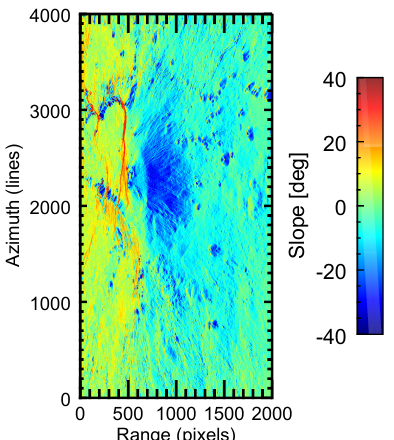
Figure 11. Local slopes of the terrain inslant − range direction of the test